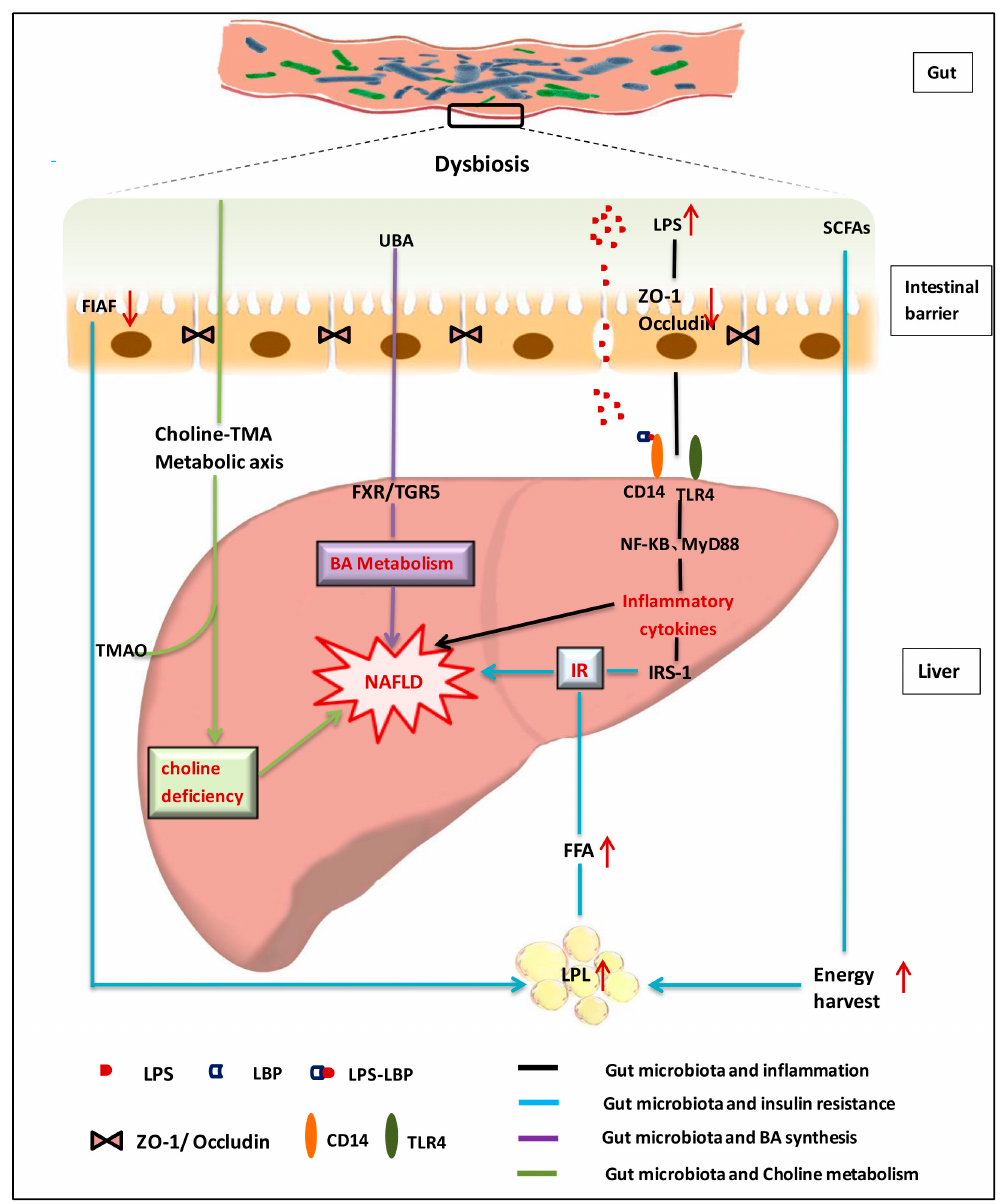
Figure 1. Schematic view on roles of gut microbiota in nonalcoholic fatty liver disease [2,48–60]. NAFLD:nonalcoholic fatty liver disease; LPS:lipopolysaccharides; LBP: LPS binding protein; NAFLD: nonalcoholic fatty liver disease; LPS: lipopolysaccharides; LBP: LPS binding protein; SCFAs : short chain fatty acids; BA:Bile acid; TNF- α : tumor-necrosis factor alpha; TLR:Toll like SCFAs:short chain fatty acids; BA: Bile acid; TNF- α : tumor-necrosis factor alpha; TLR: Toll like receptor; receptor; CD14:monocyte differentiation antigen; UBA:unconjugated bile acid; ZO-1\Occludin:two CD14: monocyte differentiation antigen; UBA: unconjugated bile acid; ZO-1 \ Occludin: two tight tight junction proteins; FIAF:Fasting-induced adipocyte factor; NF-kB : Nuclear factor- κ B; MyD88: junction proteins; FIAF: Fasting-induced adipocyte factor; NF-kB: Nuclear factor- κ B; MyD88: myeloid myeloid differentiation factor 88; FXR:farnesoid X receptor; TGR5:Takeda G protein-coupled differentiation factor 88; FXR: farnesoid X receptor; TGR5: Takeda G protein-coupled receptor 5; receptor 5; TMA: trimethylamine; TMAO : trimethylamine oxide; IR:Insulin resistance; IRS:Insulin TMA: trimethylamine; TMAO: trimethylamine oxide; IR: Insulin resistance; IRS: Insulin receptor receptor substrate; FFA:free fatty acid; LPL: lipoprteinlipase substrate; FFA: free fatty acid; LPL: